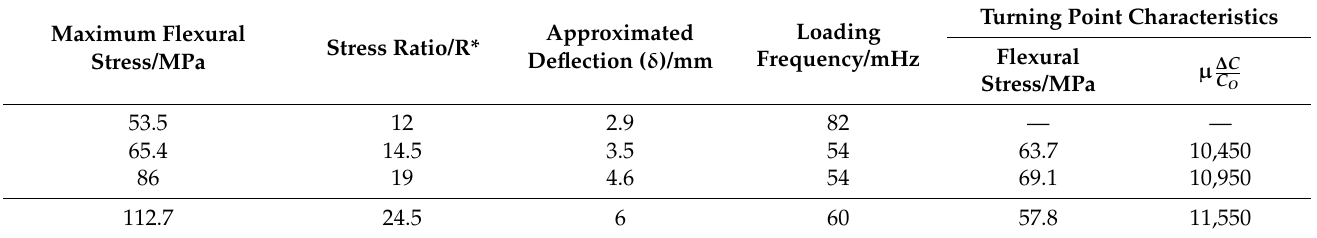
Figure 9. Time history of flexural stress and relative change in capacitance under variable amplitude loading: ( a ) 53.5 MPa where A, B and C describe the status of sample during the cyclic flexural test (refer to the experimental set-up in Figure 6), ( b ) 65.4 MPa; ( c ) the sample was initially loaded of 11 MPa up to 86 MPa, and ( d ) the sample was loaded four times at 112.7 MPa. Table 4. Electrical and mechanical results obtained from three-point bending test for type-B